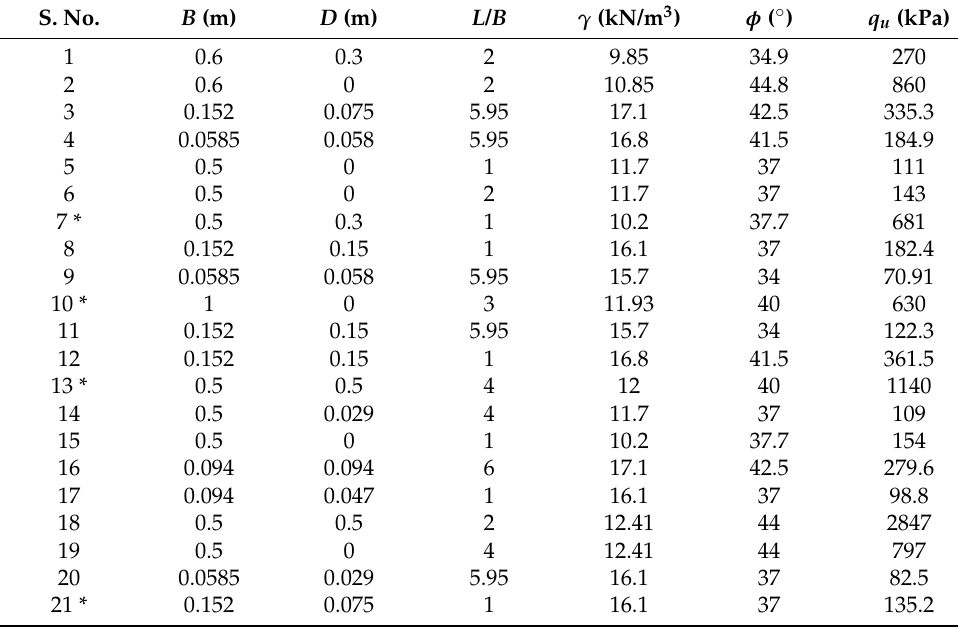
Table A1. The data used for developing the GPR